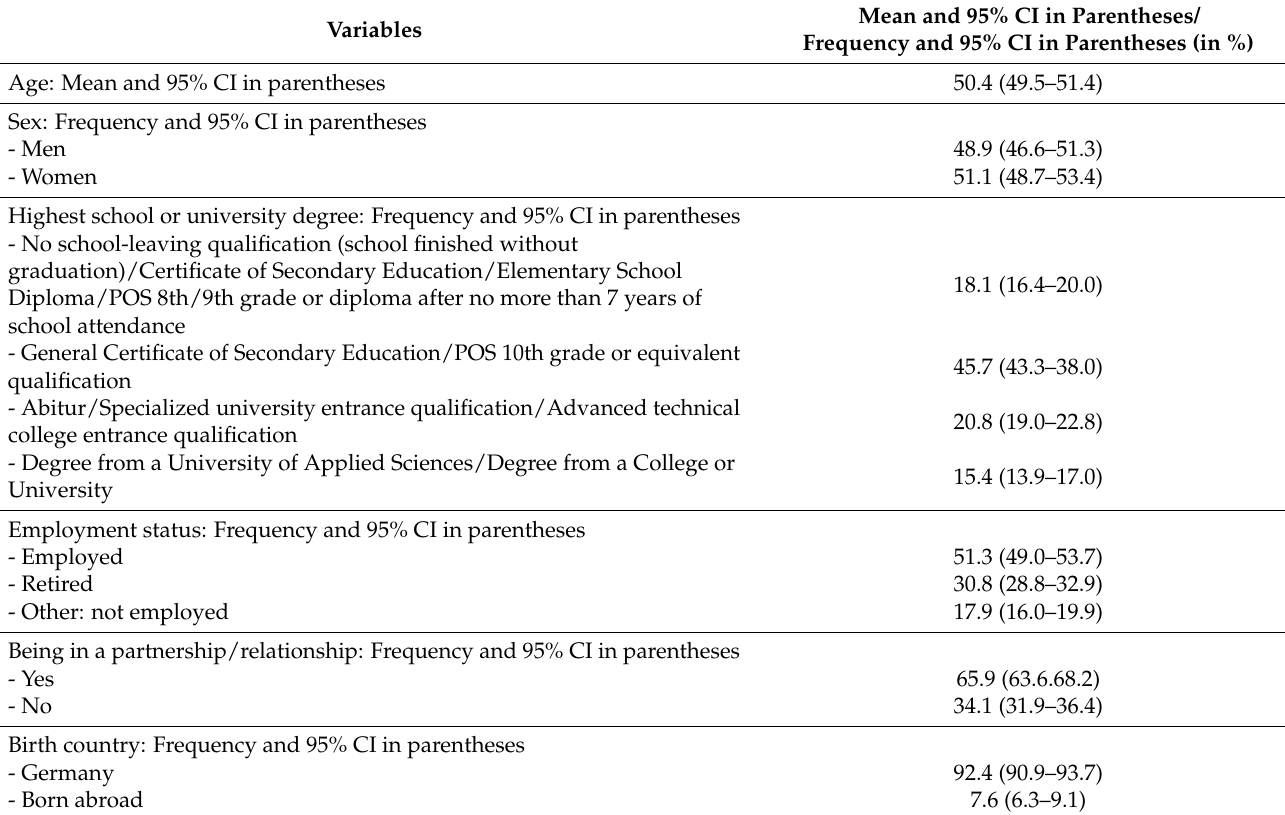
Table 1. Sample characteristics (weighted analytical sample, n = 3829). Variables